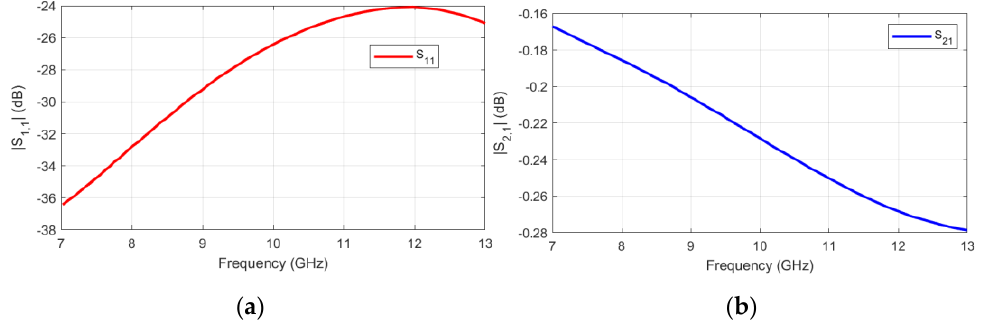
Figure 7. Return loss ( a ) and insertion loss ( b ) of the optimized microstrip – stripline – microstrip transition.